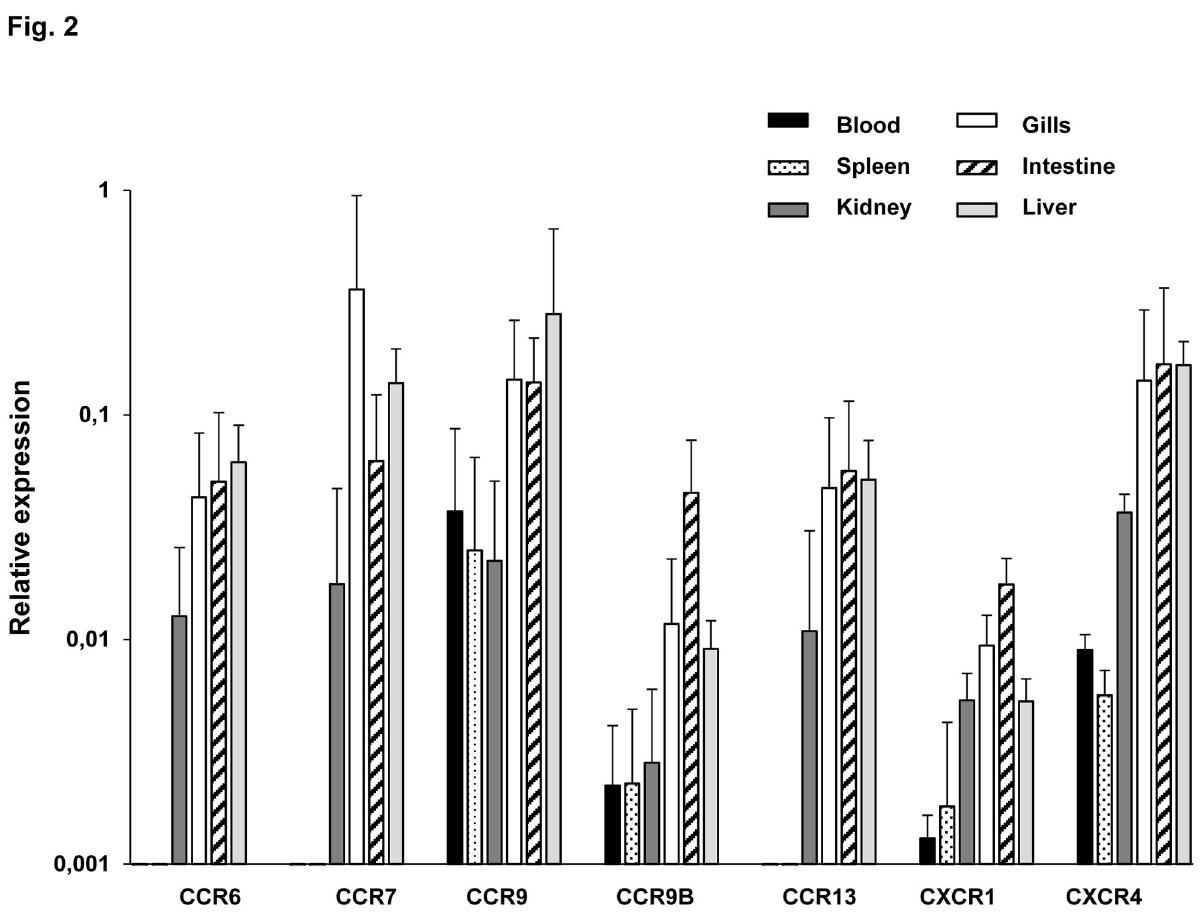
Figure 2. Levels of chemokine receptor transcription in sorted IgM + cells. Constitutive levels of transcription of CCR6, CCR7, CCR9, CCR9B, CCR13, CXCR1 and CXCR4 in isolated IgM + cells from different trout tissues. Levels of transcription were evaluated through real time PCR in duplicate. Data from 5 independent experiments are shown as the mean gene expression relative to the expression of an endogenous control (EF-1α) ±